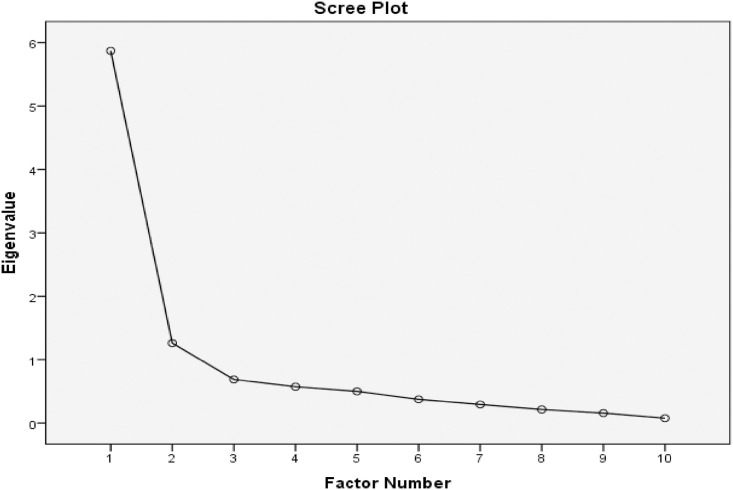
The number of constructs in the Healthcare Professional-Medication Adherence Instrument (H-MAI).